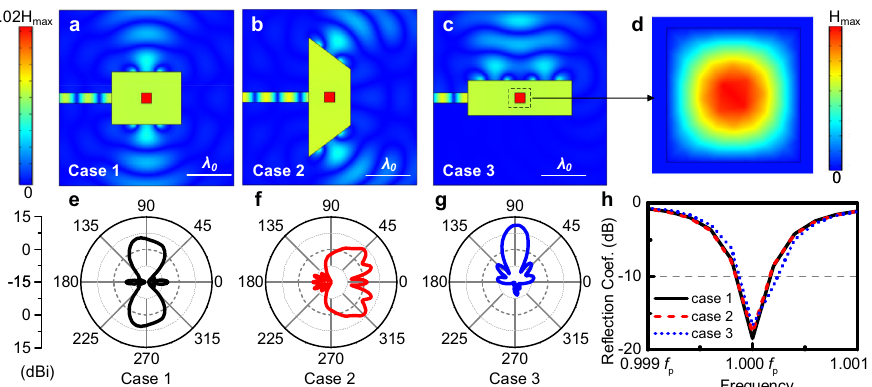
Fig. 2 Numerical veri fi cations of the shape- fl exible properties of 2D structures. a – c Snapshots of the simulation results of magnetic fi elds of cases 1 – 3. The sizes of the rectangular ENZ hosts in case 1 – 3 are 1.54(1.15 λ 0 2 (80(60 mm 2 ) and 2.31(0.77 λ 0 2 (120 × 40 mm 2 ). In case 2, a trapezoid with their four sides being 2.62 λ 0 (136 mm), 1.15 λ 0 (60 mm), 1.23 λ 0 (64 mm), and 1.15 λ 0 (60 mm) is used. The slots, waveguides, and the dopants are the same in all con fi gurations. d A time snapshot of the magnetic fi eld inside the dopant. e – g Simulation results for the far- fi eld radiation gain patterns of the antennas with different shapes and ( h ) the re fl ection coef fi cients for the three